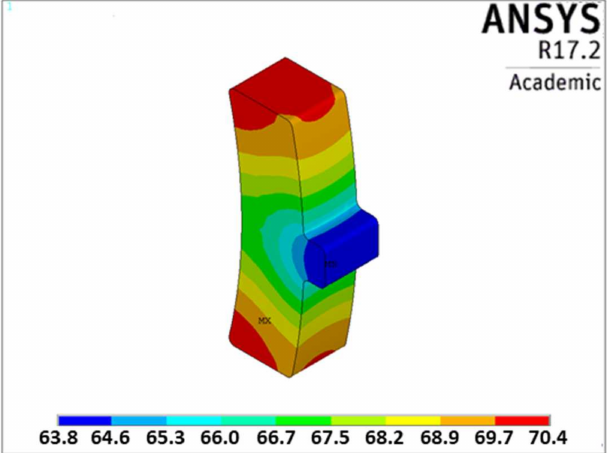
Figure 5. Braking maneuver A—Temperature of the brake block when the maximum temperature is reached at the position where the sensor is